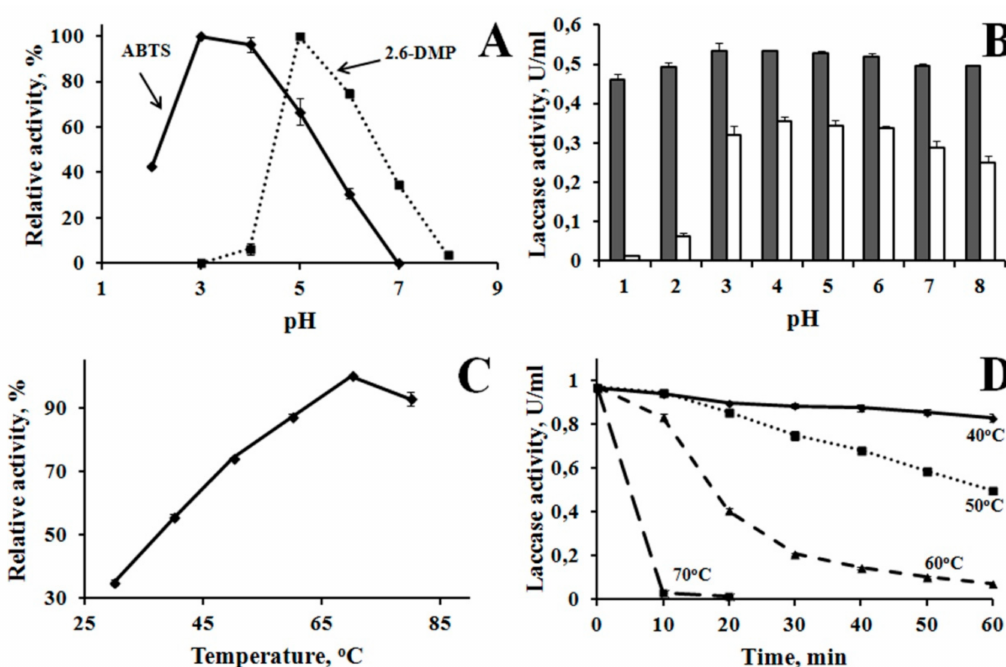
Figure 3. Properties of M. elasson laccase. ( A )—optimum pH, ( B )—pH stability: gray bars—initial activity, white bars— laccase activity after 4 days. ( C )—temperature optimum of the reaction, ( D )—thermostability at 40–70 ◦ C. The experimental data presented in Supplementary Materials—“supplement properties.xlsx”.